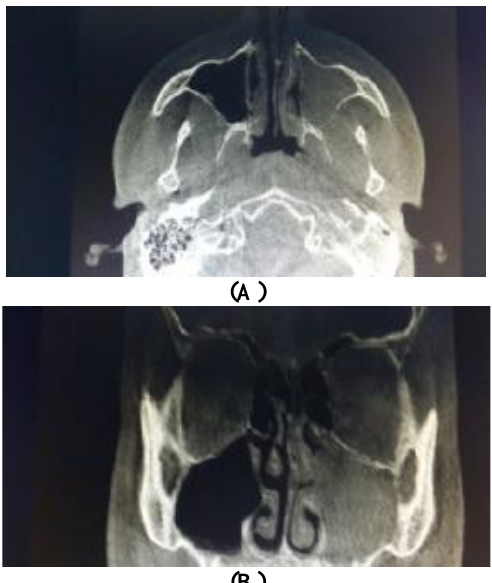
Figure 3: (A) Axial & (B) Coronal Showing Full Opacification of the Lt. Maxillary